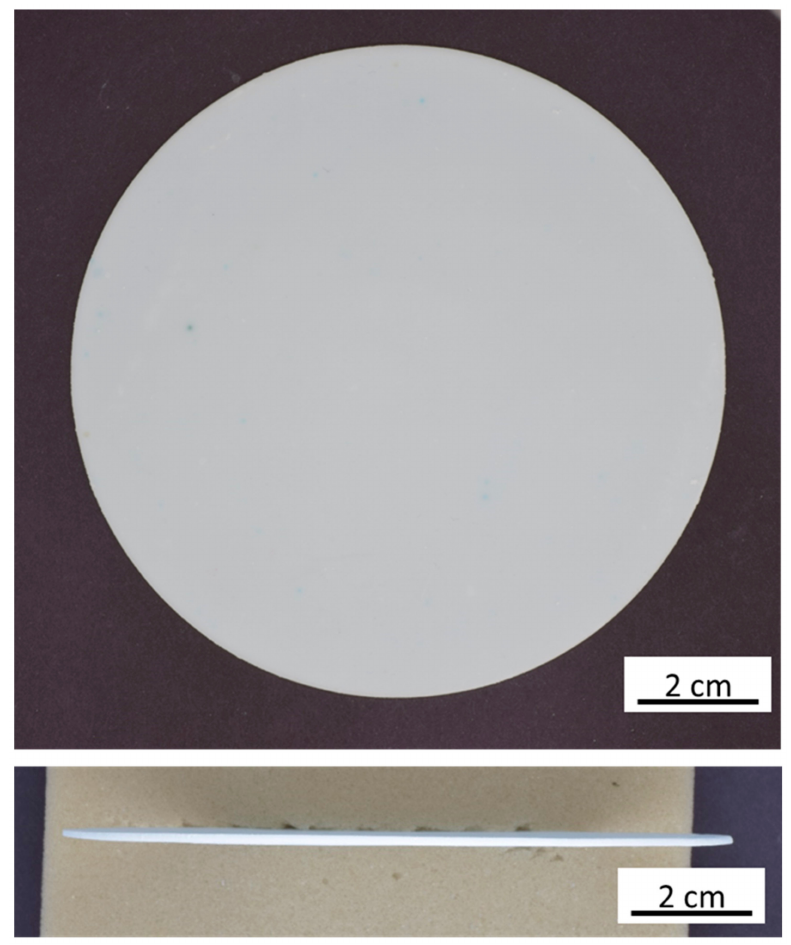
Figure 3. One hundred and ten mm diameter planar BASE membrane after